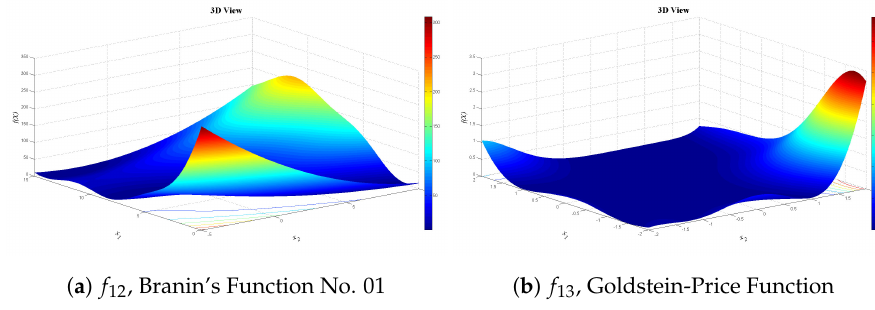
Figure 9. Multimodal functions with fixed dimensions f 12 and f 13 in a 3D